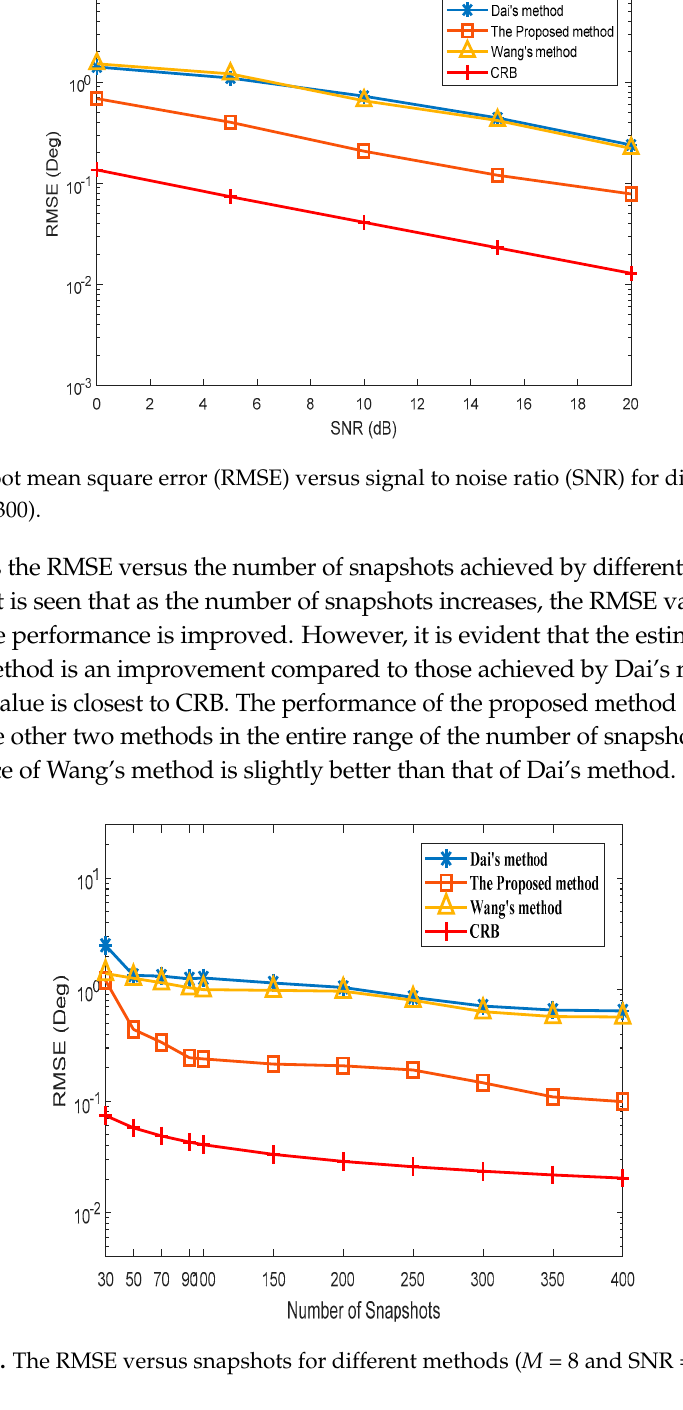
Figure 1. The spatial spectrum of the proposed method, Wang’s method, and Dai’s method.